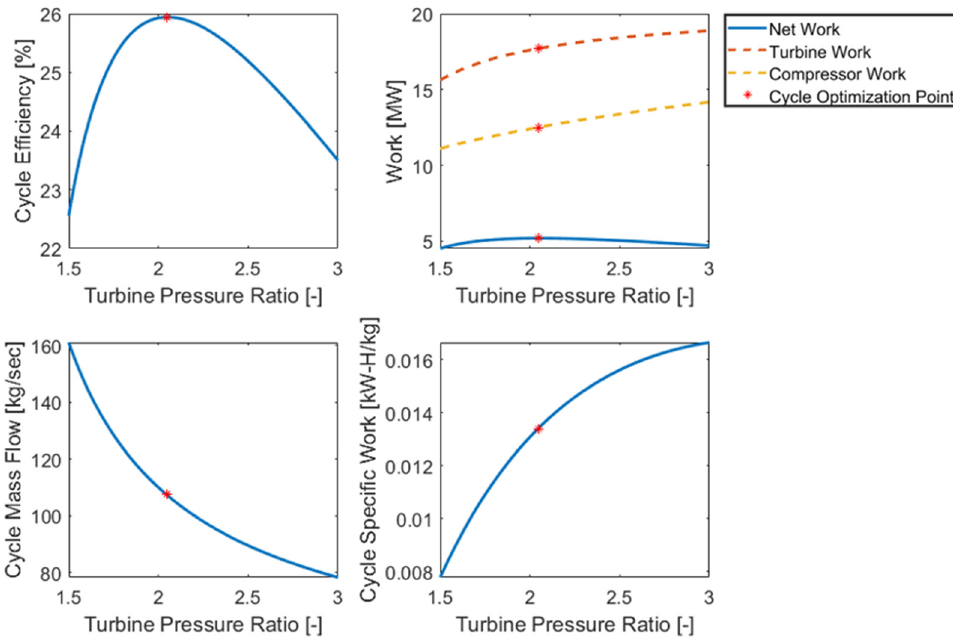
Figure 11. KAIST-CCD Optimization Result for S-CO 2 Brayton Cycle.